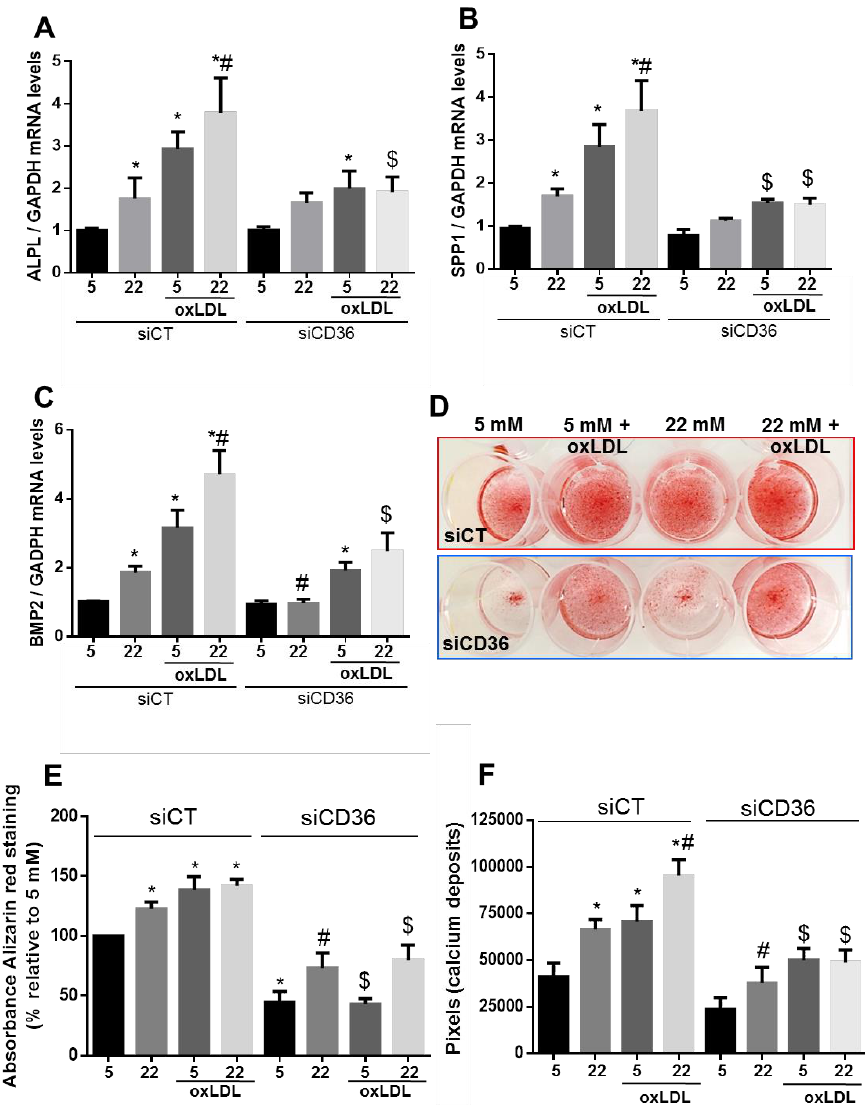
Figure 5. Silencing of CD36 reduces the effect of HG and oxLDL on VSMC calcification. ( A – C ) ALPL, BMP2, and SPP1 mRNA levels quantified by qPCR analysis in VSMC cultured with NG or HG conditions and treated or not with oxLDL after silencing CD36 ( n = 5). ( D ) Representative picture of VSMC stained with alizarin red that were transfected with siRNA-CT or siRNA-CD36 and cultured in an osteogenic medium for 7 days with NG or HG ± oxLDL. ( E ) Quantification of alizarin red staining by colorimetry ( n = 5). ( F ) Quantification of alizarin red staining by imaging analysis ( n = 5). Results are expressed as mean ± SEM. * p < 0.05 vs. 5 mM siRNA-CT or siRNA-CD36; # p < 0.05 vs. 22 mM siRNA-CT; $ p < 0.05 vs. 22 mM + oxLDL siRNA-CT or 5 mM + oxLDL